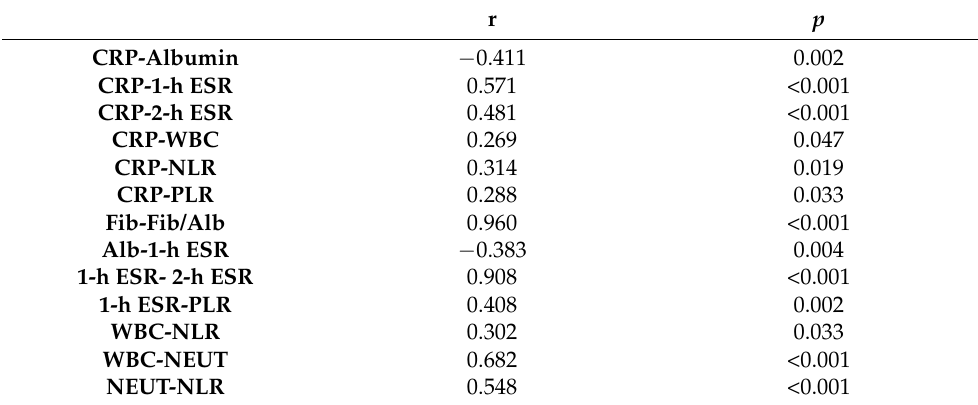
Table 4. Correlation analysis in IGM